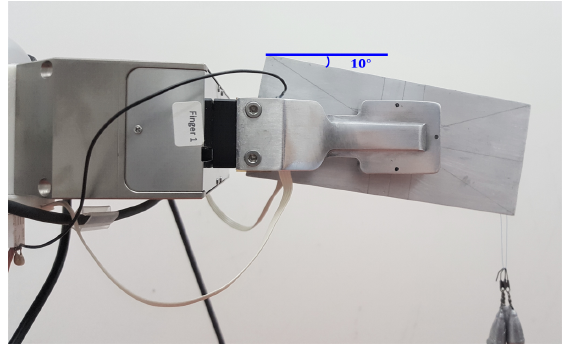
Figure 23. Fifth experiment: Grasp for the validation of the calibration of the torsional moment component.